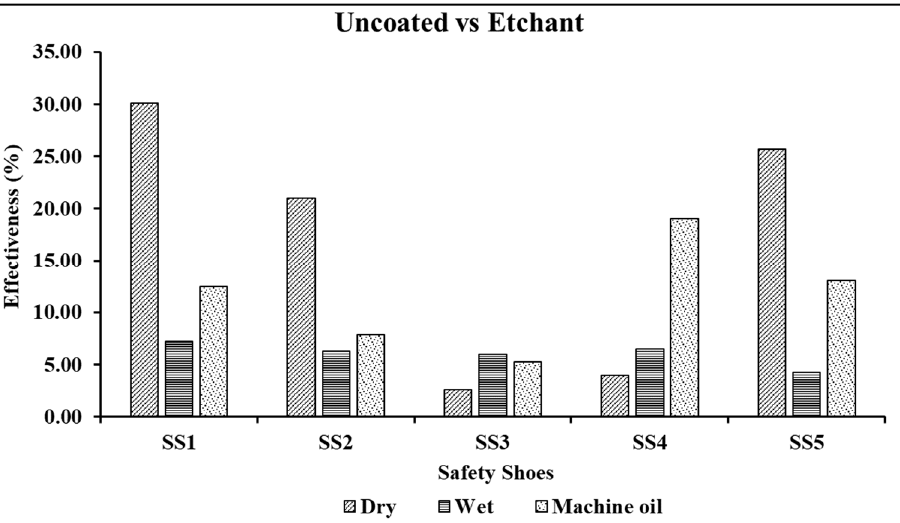
Figure 8. Effectiveness of etchant-based coating as compared to uncoated laminate flooring across dry, wet, and machine oil contaminant conditions.